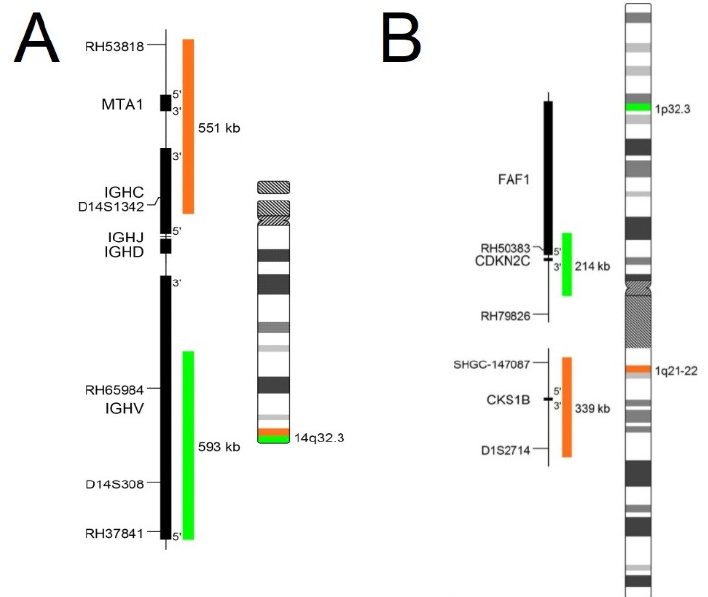
Figure 1. Probe map of chromosome 14 and chromosome 1 with visualization of target genes, their sizes, and fluorescent dye used on visualization. ( A ) Map of break-apart probe of IGH gene capable of detected aberration: deletion, amplification, and breakage in gene; ( B ) Map of numerical probe on chromosome 1 able to detect only numerical changes: deletion and additions of material [17].